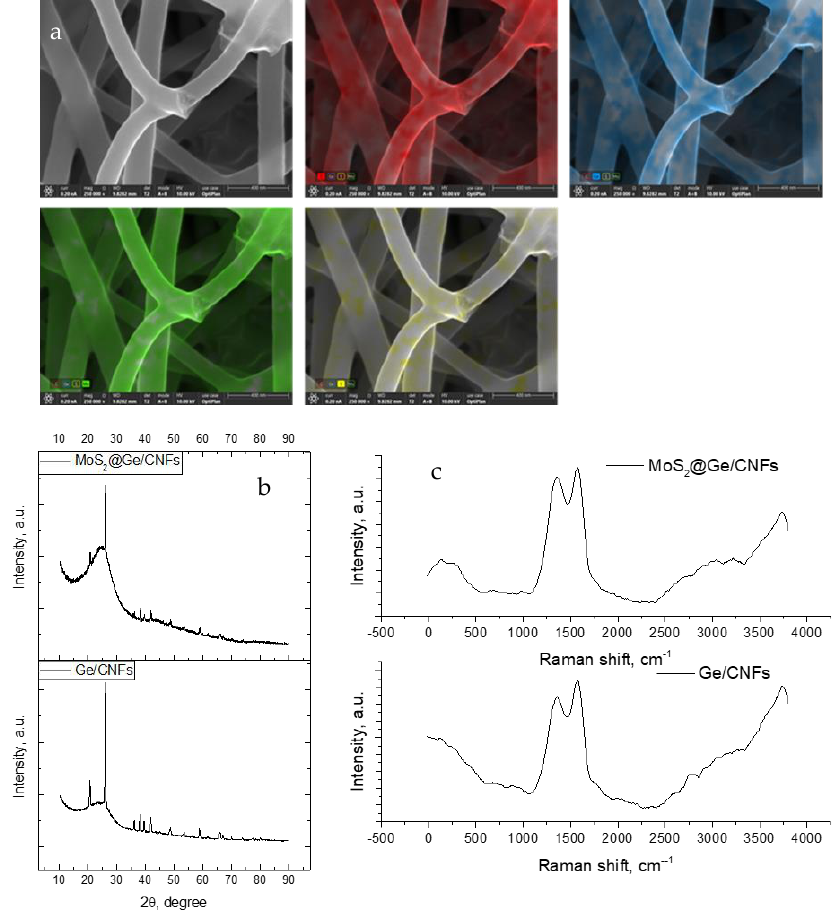
Figure 3. ( a ) EDX mapping and spectrum of the flexible MoS 2 @Ge/CNFs; ( b ) XRD pattern and ( c ) Raman spectra of the flexible Ge/CNFs and MoS 2 @Ge/CNFs.